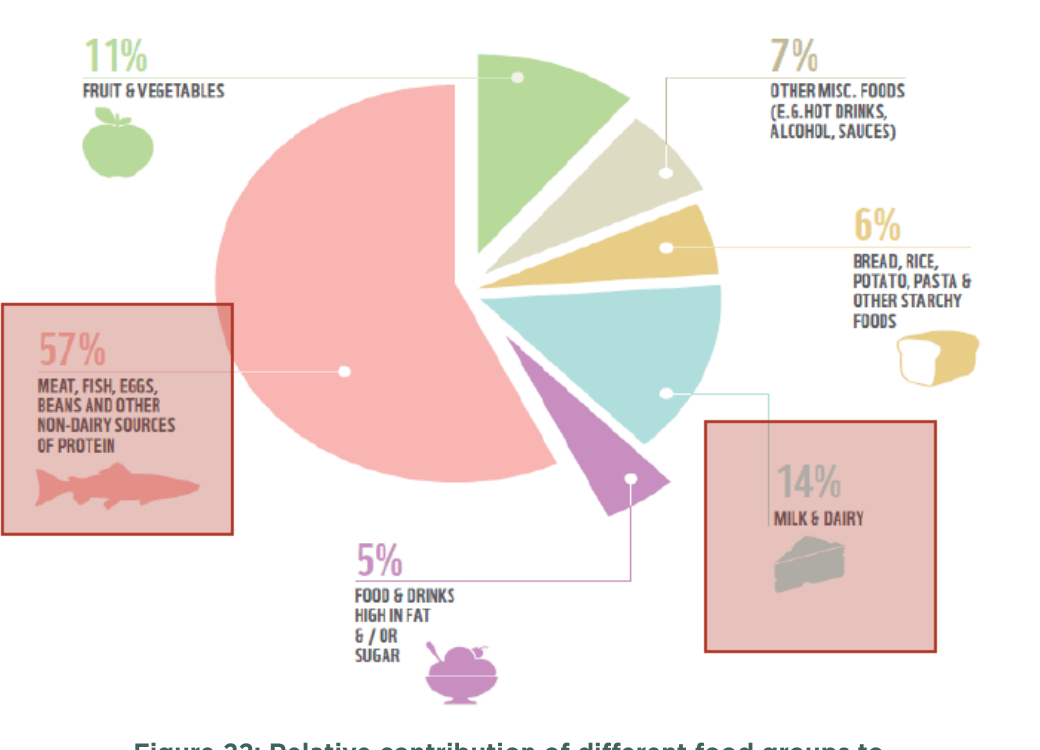
Figure 22: Relative contribution of different food groups to diet related GHG